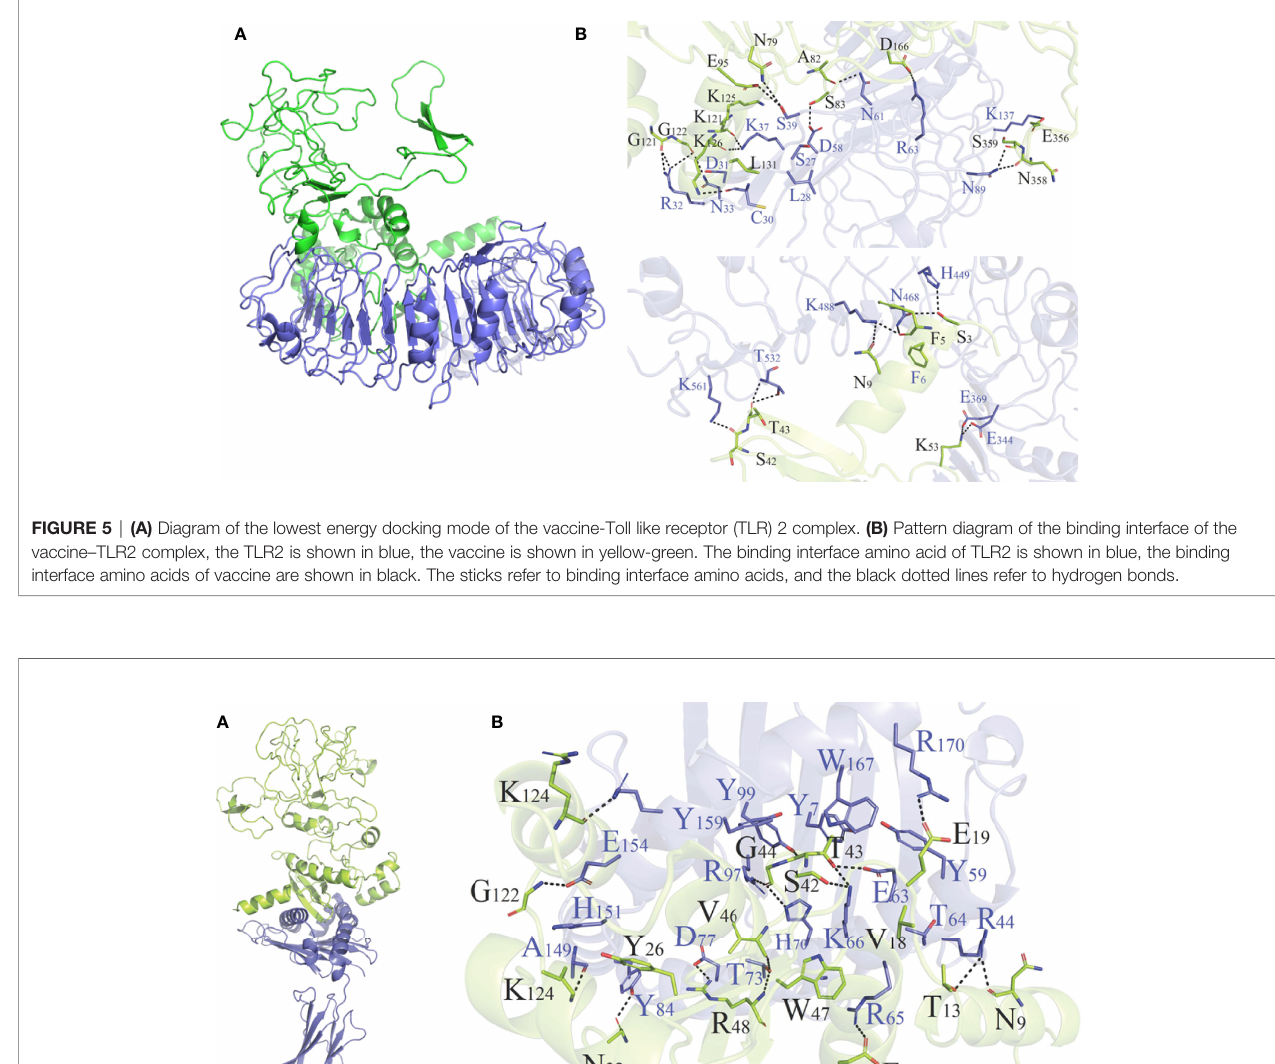
FIGURE 6 | (A) Diagram of the lowest energy docking mode of the vaccine – HLA-A*02:01 complex. (B) Pattern diagram of the binding interface of the vaccine – HLA-A*02:01 complex, the HLA-A*02:01 is shown in blue, the vaccine is shown in yellow-green. The binding interface amino acid of HLA-A*02:01 is shown in blue, the binding interface amino acids of vaccine are shown in black. The sticks refer to binding interface amino acids, and the black dotted lines refer to hydrogen